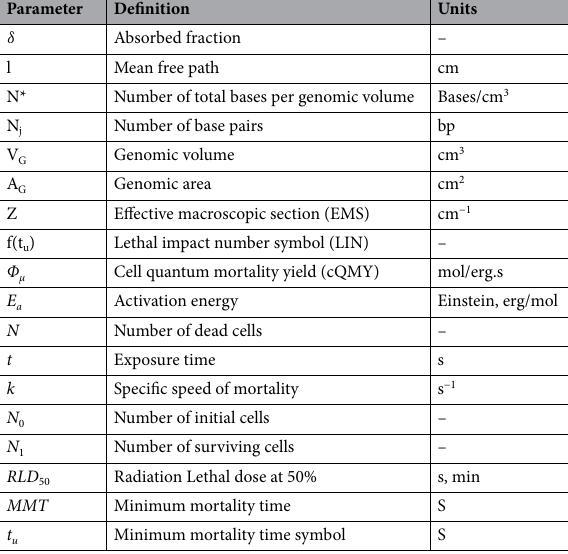
Table 2. Definition of the parameters used at physical and mathematical modeling (−) adimensional